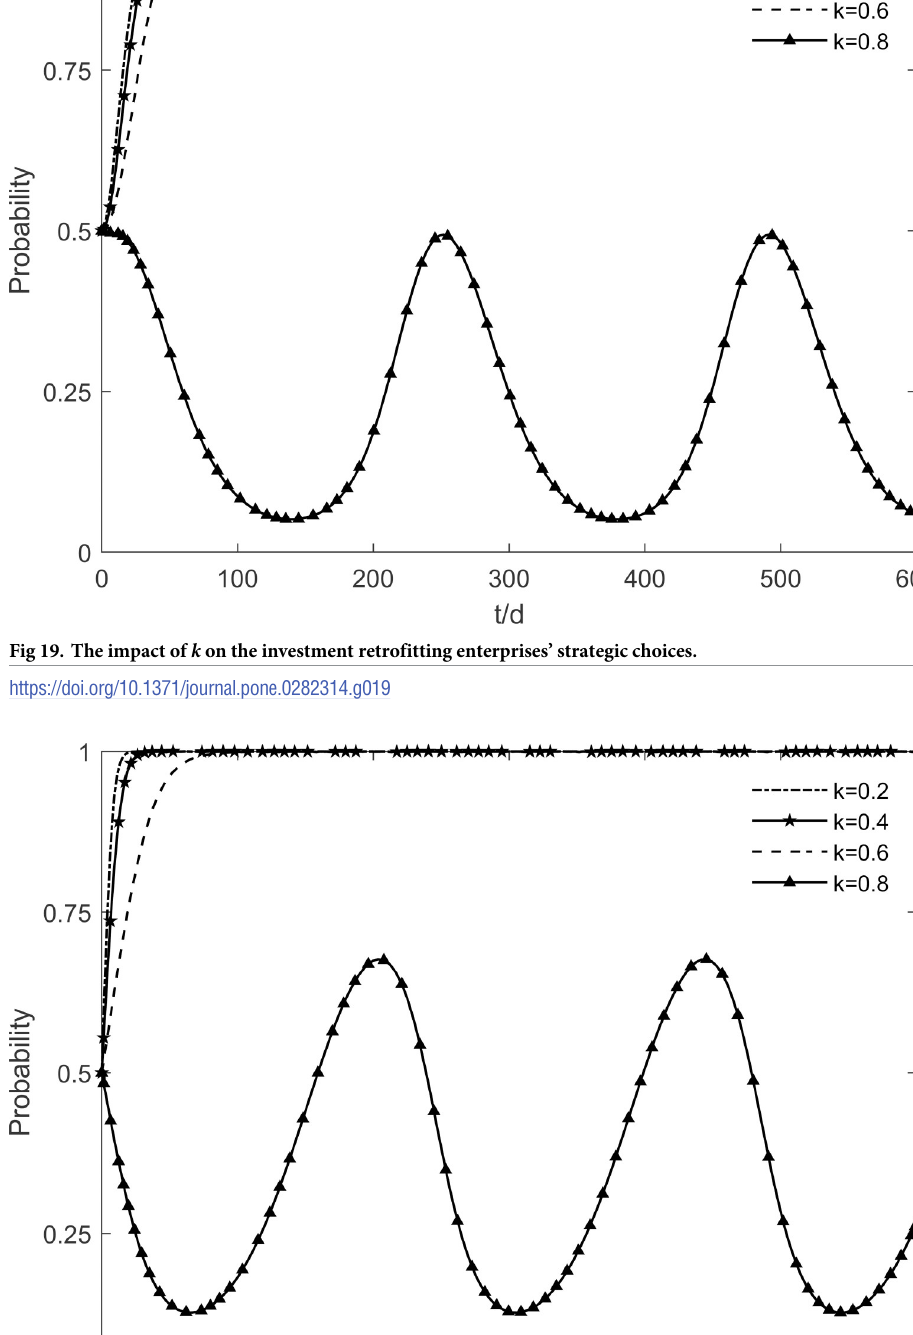
PLOS ONE | https://doi.org/10.1371/journal.pone.0282314 March 16,